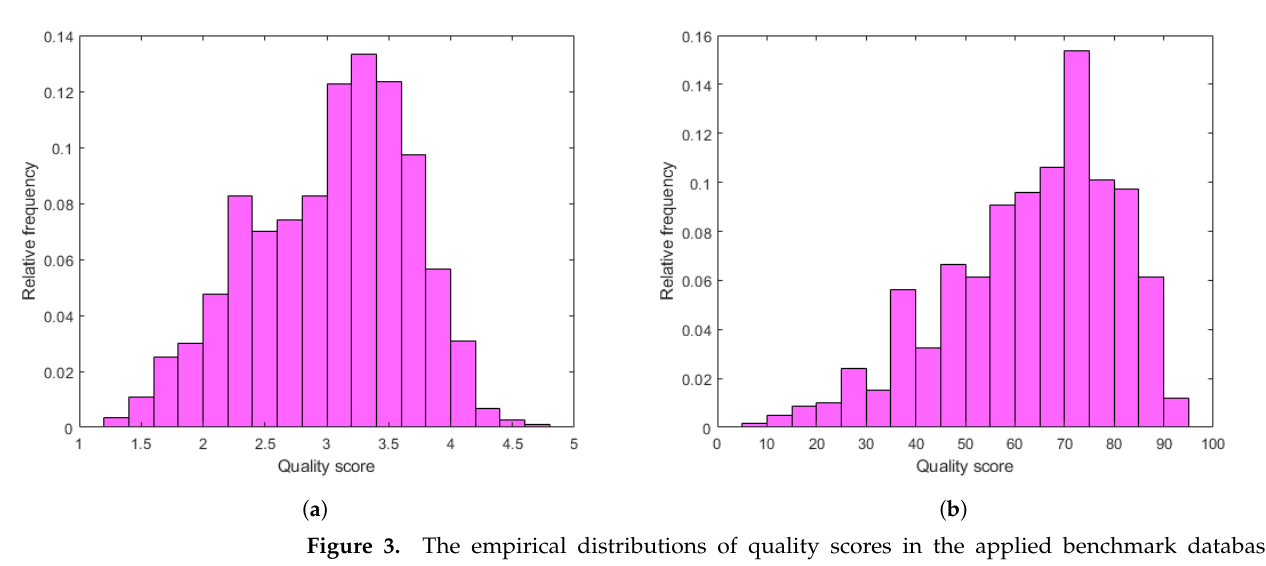
Figure 3. The empirical distributions of quality scores in the applied benchmark databases: and from 0.0 to 100.0 in LIVE VQC